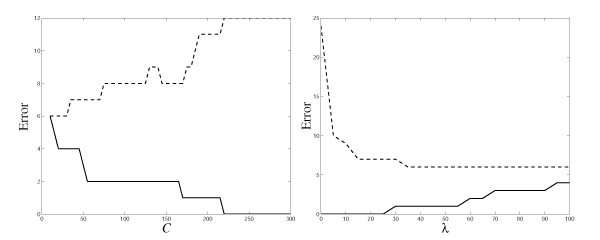
: LOO error (dotted line) and empirical risk (solid line) w.r.t the regularization parameter obtained on Colon data set by using a) SVM and b) RLS classifiers.